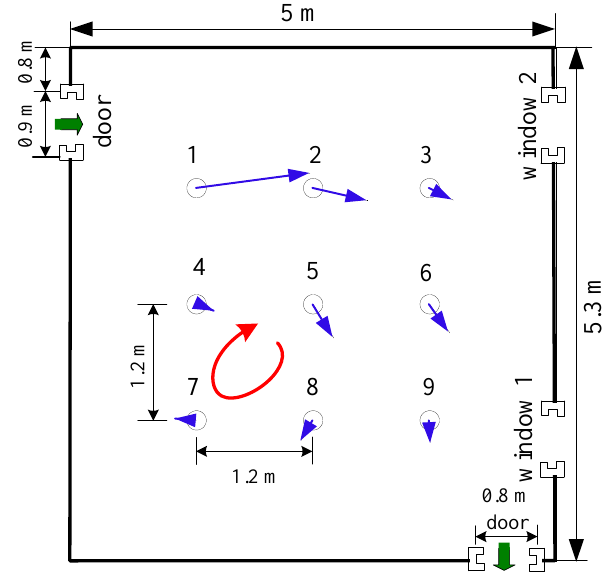
Figure 8. The average natural wind speed and direction of each anemometer over 150 seconds in Arena I. The arrows indicate the directions of the airflow and their lengths indicate the speeds. Notice the large eddy in the lower left corner.